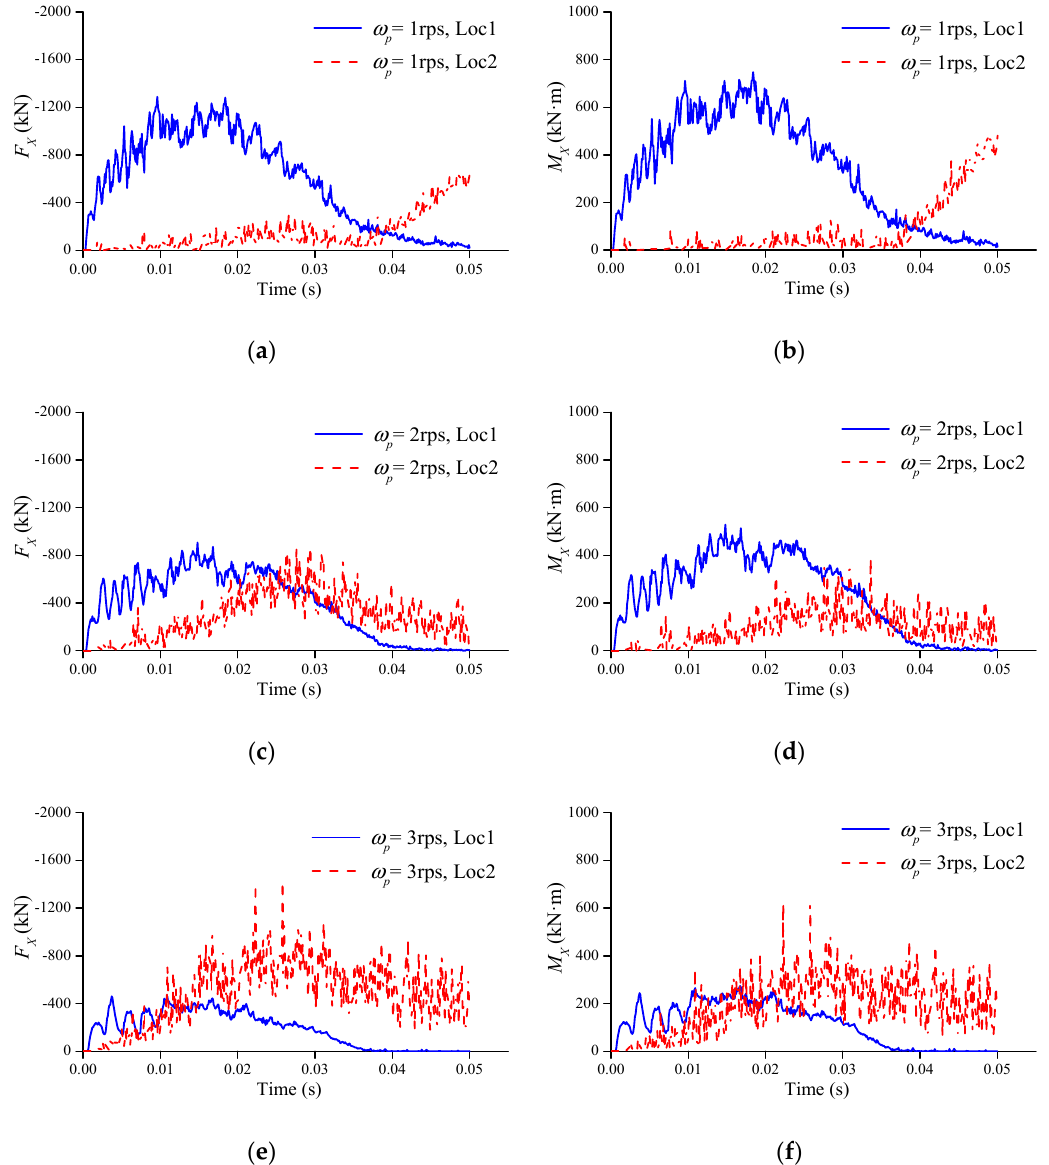
Figure 25. Time series of ice load Fx and Mx based on simulations with di ff erent collision locations. ( a ) The Fx with 1 rps. ( b ) The Mx with 1 rps. ( c ) The Fx with 2 rps. ( d ) The Mx with 2 rps. ( e ) The Fx with 3 rps. ( f ) The Mx with